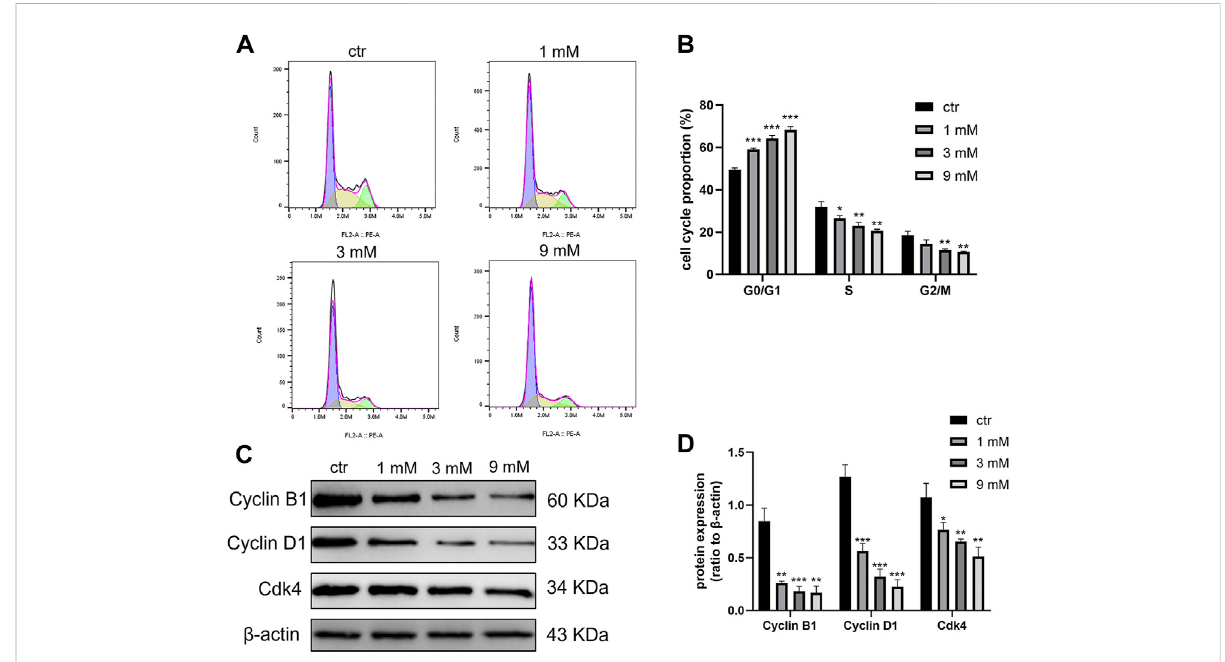
FIGURE 4 Cell cycle was blocked at the G0/G1 phase by metformin treatment on Daoy cells. (A,B) Flow cytometry was used to detect cell cycle distribution on Daoy cells after 24 h of metformin treatment ( n = 3). (C,D) The proteins associated with the cell cycle were analyzed using western blotanalysis.TherelativeCyclinB1,CyclinD1,andCdk4levelswerenormalizedtothatof β -actin( n =4).Dataarepresentedasthemean±SD,t-tests were used to determine the signi fi cance. * p < 0.05; ** p < 0.01; *** p < 0.001 compared with the control group.